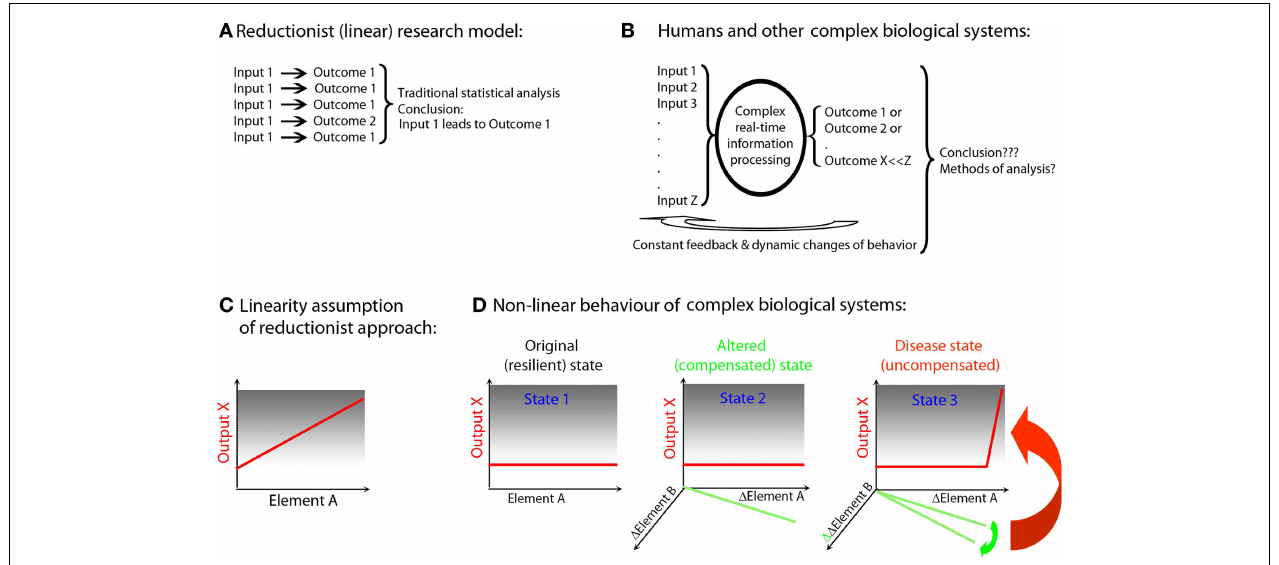
FIGURE 1 | Simplified animal models versus complex biological systems exemplified by human polygenic diseases . (A) Reductionist (linear) research model (e.g., experimental autoimmune encephalomyelitis): current animal studies are almost exclusively performed in a single animal species